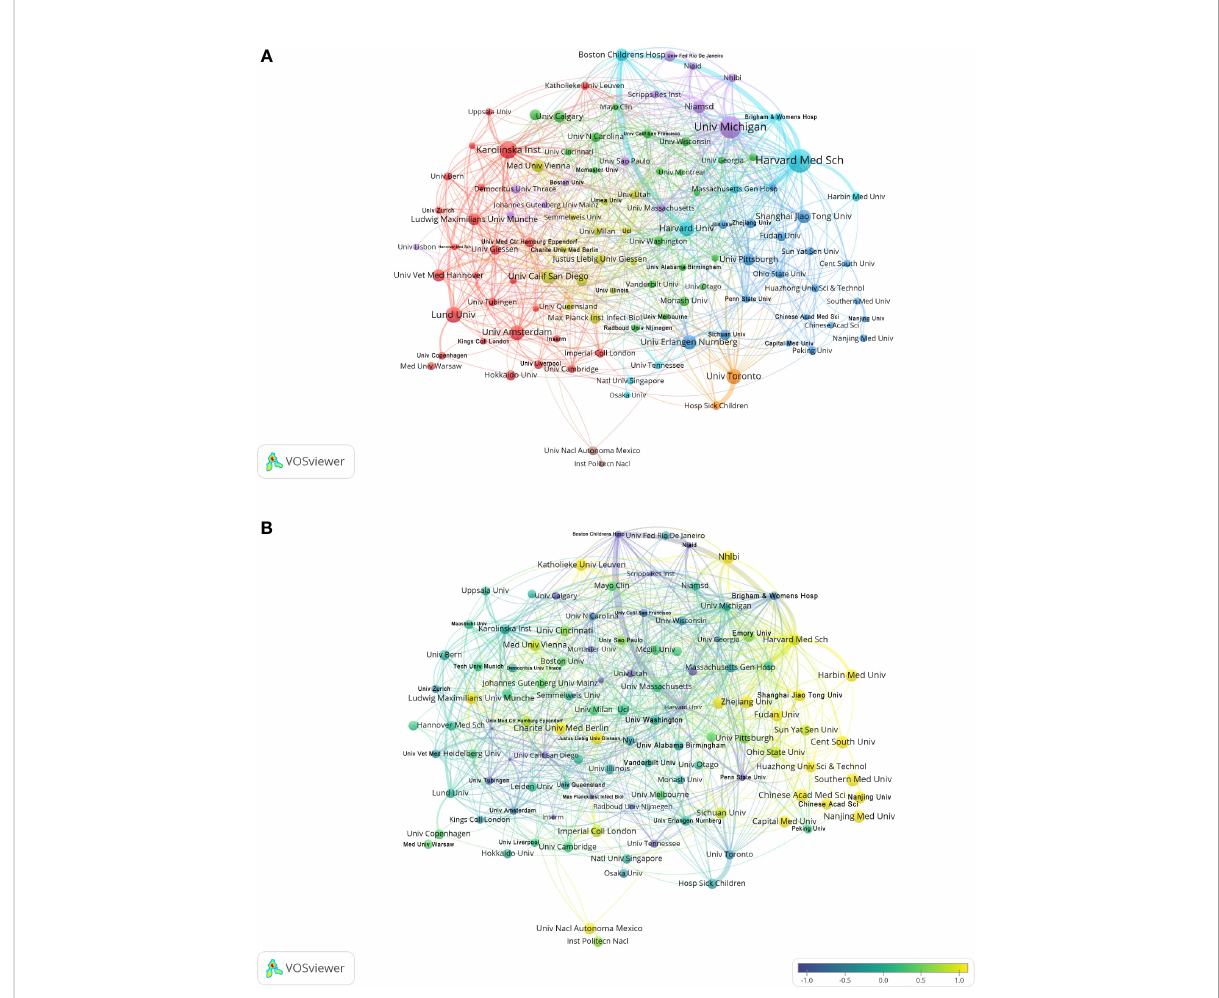
FIGURE 3 Analysis of NETs-related institution. (A) Analysis of collaborative network visualization of institutions in VOSviewer. The fi gure shows the institutions with more than 5 documents. The nodes of different colors represent the institutions of different clusters, and the size of the nodes indicates the frequency of their occurrence. (B) Analysis of the number of articles published by institutions in recent years. The recent 5 years heat value of each institution is obtained by dividing the number of publications in recent 5 year by the total number of